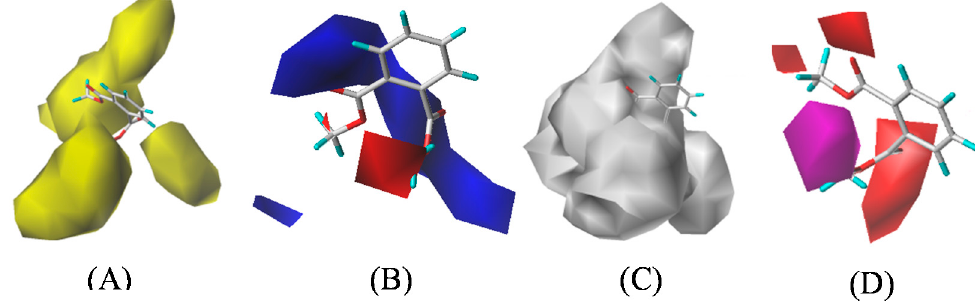
Figure 1. Dimethyl phthalate’s (DMP’s) three-dimensional contour maps of the steric field ( A ), electrostatic field ( B ), hydrophobic field ( C ), and hydrogen bond acceptor field ( D ) in the multi-effect CoMSIA model.